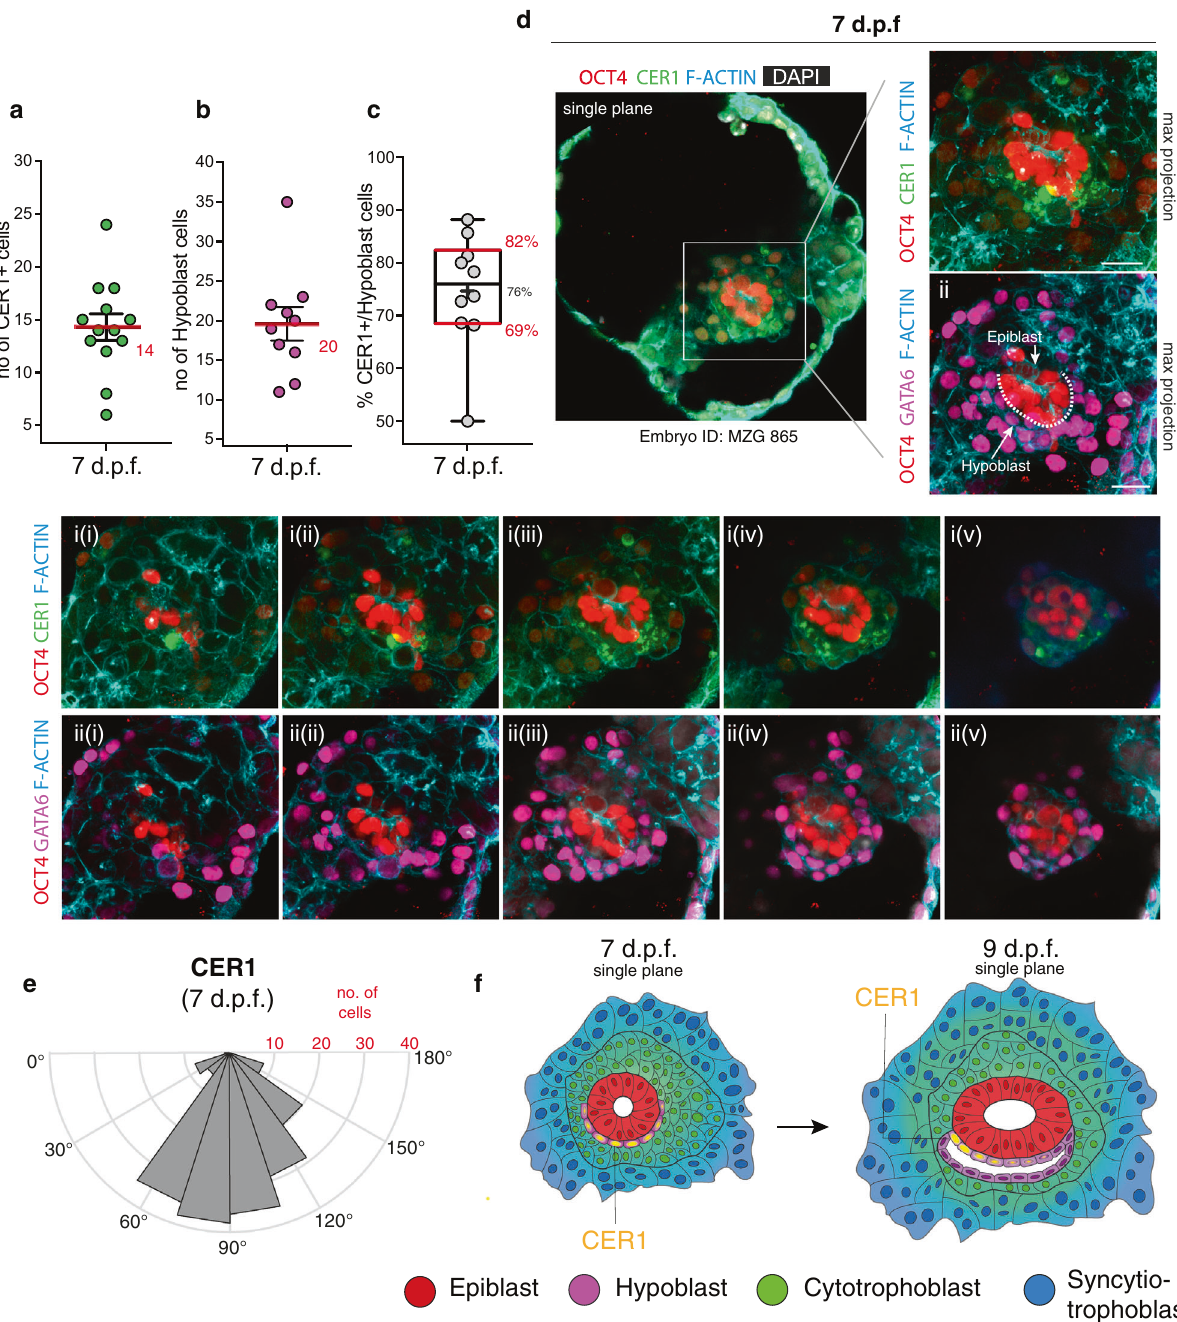
Fig. 4 Characterisation of the putative anterior hypoblast in the human embryos at 7 d.p.f. a Quanti fi cation of the number of CER1 expressing cells ( n = 13 embryos, mean in red ± SEM). b Quanti fi cation of the number of hypoblast cells as GATA6 + cells lining the basal side of epiblast ( n = 10 embryos, mean in red ±SEM). c Percentage of hypoblast cell expressing CER1. Boxes represent the 25th and 75th percentiles, red line the median, cross the mean, whiskers the min and max values, dots individual embryos ( n = 10 embryos). N experimental replicates: 5. d Immuno fl uorescence analysis of embryos at 7 d.p.f. reveals the widespread distribution of CER1 cells along the hypoblast, marked by GATA6 along the basal side of the epiblast epithelium (ii). N experimental replicates: 5. N(embryos) analysed: 13 e Quanti fi cation in 3D of the angular distribution of CER1 expressing cells along the hypoblast hemisphere at 7 d.p.f. (0° to 180°). N embryos: 10. f Model of the establishment of the putative anterior hypoblast centre: initially at 7.d.p.f. the putative anterior hypoblast centre is radially expressed throughout most of the cells of the hypoblast and particularly enriched distally. At 9.d.p.f. the putative anterior hypoblast centre becomes localised asymmetrically to one side of the hypoblast, repressing the activity of key signalling pathways such as BMP on the adjacent epiblast. Asymmetric activity may discriminate the future anterior region from the prospective posterior region of the epiblast, where gastrulation will occur. Scale bars: 50 μ m (4a, zoom out), 25 μ m (4d, i – xii). Source data are provided as a Source Data fi